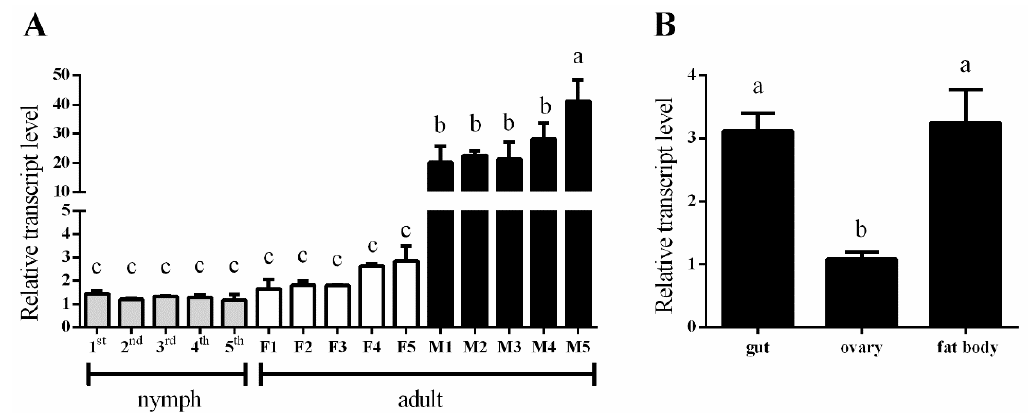
Figure 2. Expression of NlPCE3 in different developmental stages and tissues. ( A ) Expression patterns of NlPCE3 in different developmental stages, including 1 st to 5 th nymphs, adults of F (one- to five-day-old macropterous females) and M (one- to five-day-old macropterous males). ( B ) Expression patterns of NlPCE3 in the gut, ovary, and fat body of macropterous females. Data are presented as the mean ± standard error. Different lower-case letters above the bars indicate significant differences (one way ANOVA was performed using GraphPad Prism Software 6.0, p < 0.05).